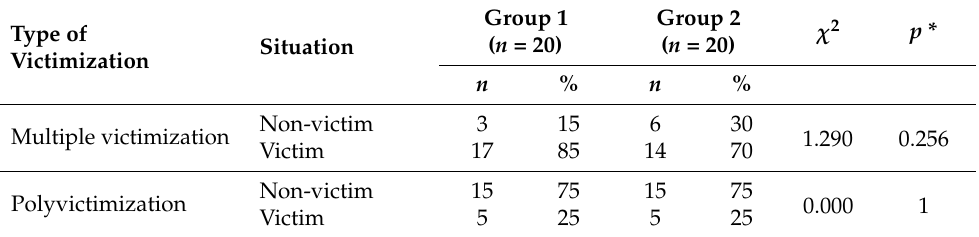
Table 4. Characterization of multiple victimization and polyvictimization between